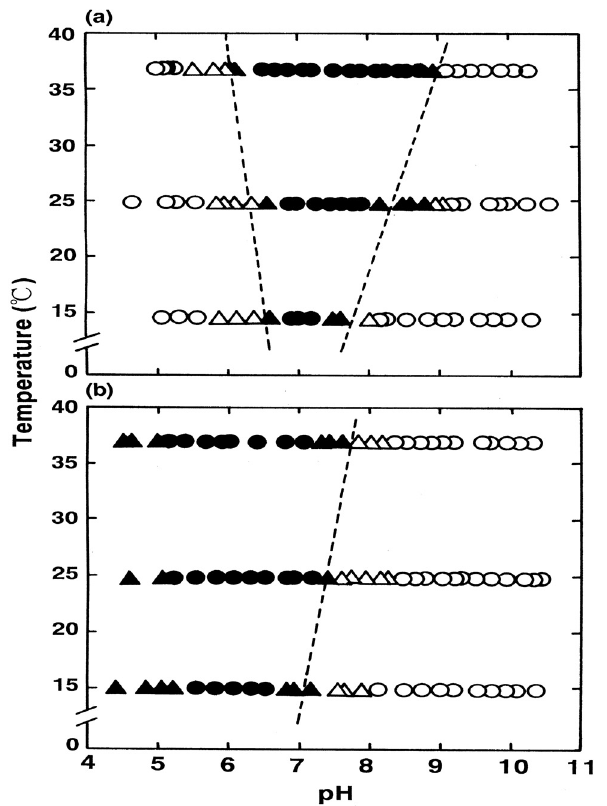
6. Hemichrome formation for isolated α and β chains, redrawn from Sugawara et al . [20]. ( a ) pH-temperature diagrams for hemichrome formation observed in isolated α chains and ( b ) β chains. The symbols are identical to those shown in Figure